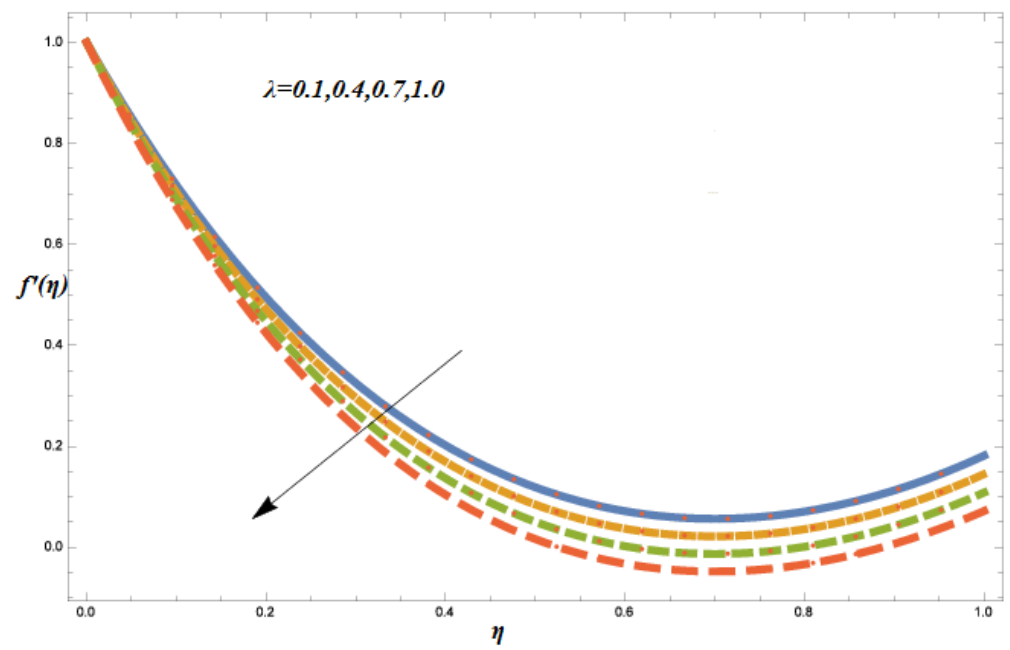
Figure 21. Variations in velocity field f (cid:48) ( η ) for various values of λ , when (cid:125) = − 0.25, P r = 10, S c = 0.7, Λ = 0.7, D u = 0.7, β = 1, S = 0.7.